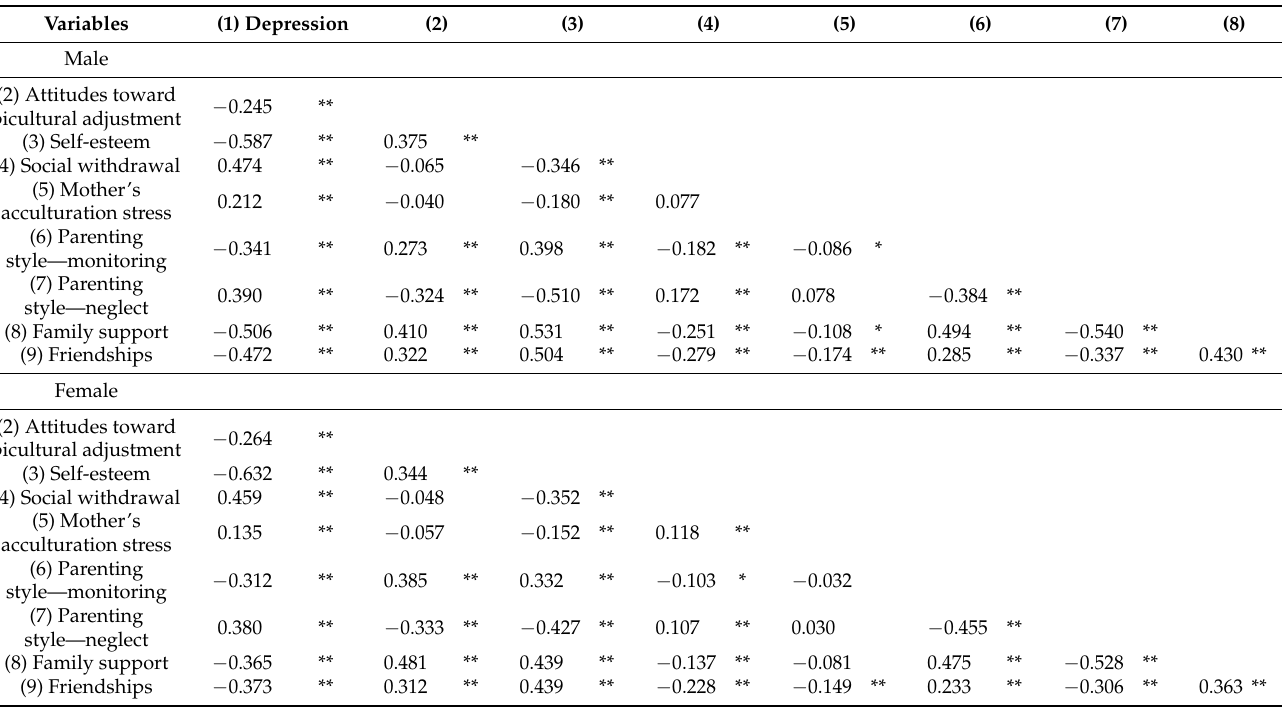
Table 3. The relationship among research variables according to gender of multicultural